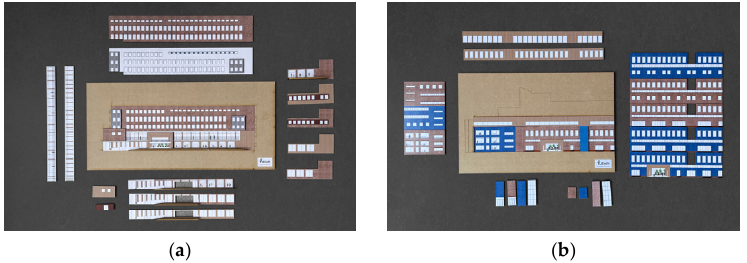
Figure 3. ( a ) 2,5D model for redesign testing (west facade); ( b ) 2,5D model for redesign testing (north facade).